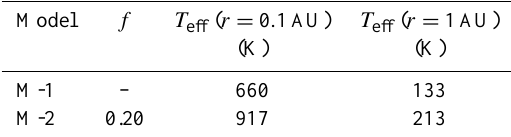
Table 1. Effective temperature T eff of the disk as a function of